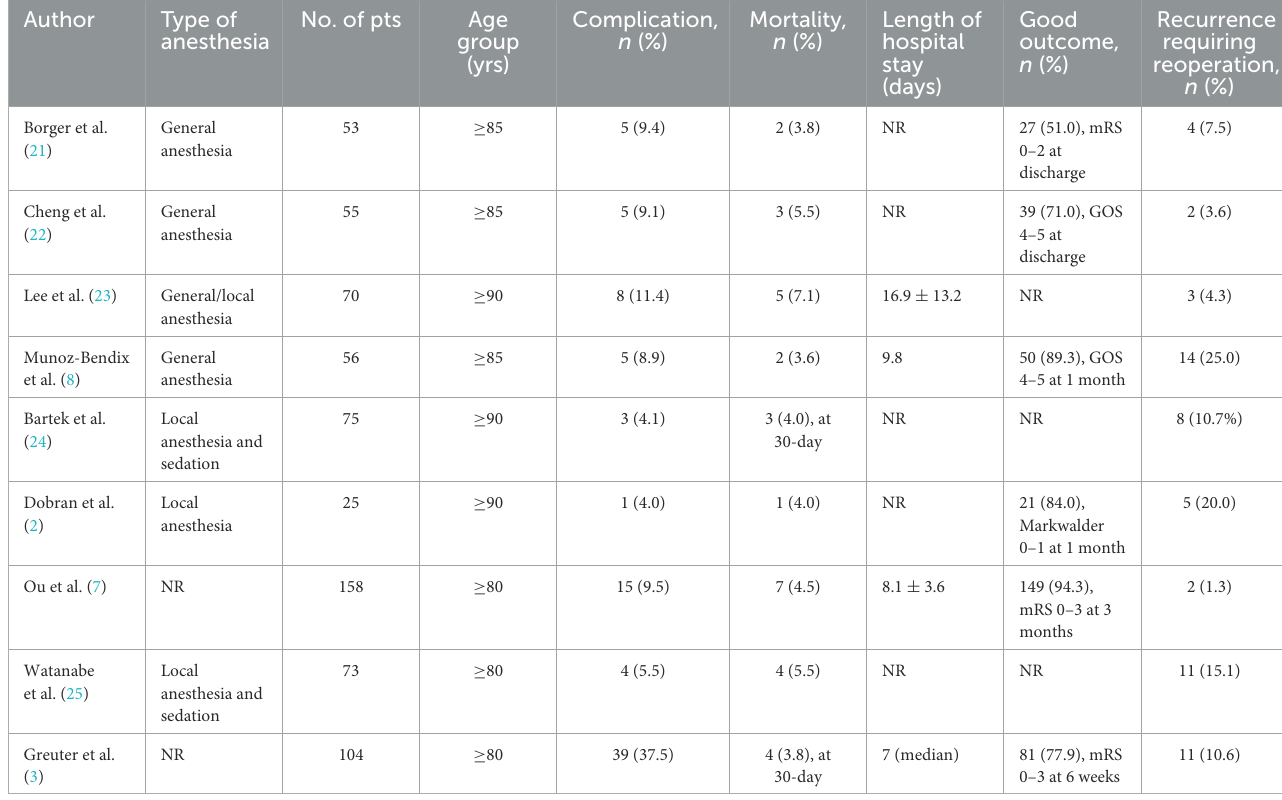
TABLE 3 Summary of prior studies on burr-hole drainage for CSDH in very elderly patients older than 80